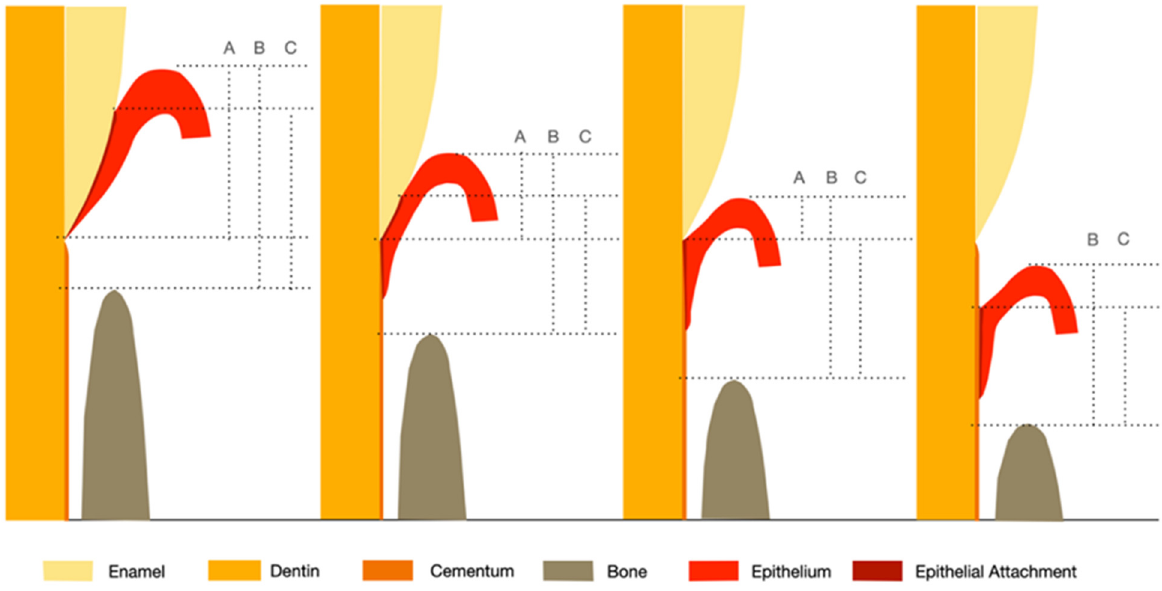
Figure 1. Four different stages of passive eruption. A: Negative gingival recession; B: total length of dentogingival junction, including the sulcus depth, epithelial attachment, and connective tissue attachment; C: supracrestal tissue attachment, including epithelial attachment and connective tissue attachment (adapted from Gargiulo et al., 1961 [8]).